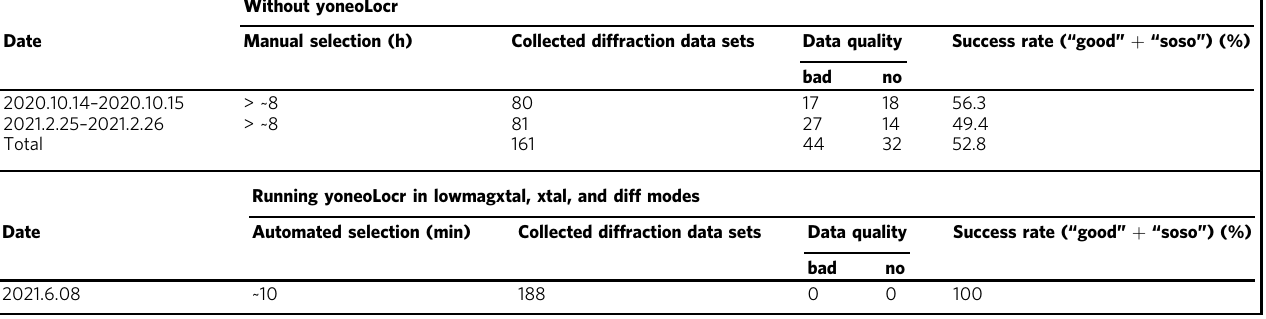
Table 3 Typical data statistics for automated cryo-EX data collection with and without running